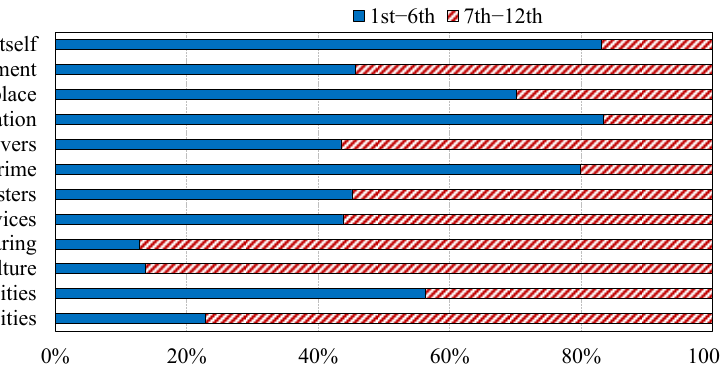
Figure 3. Percentage of respondents ranking each of the factors in the top (Rank 1st–6th) or bottom (7th–12th) categories ( n = 1554).